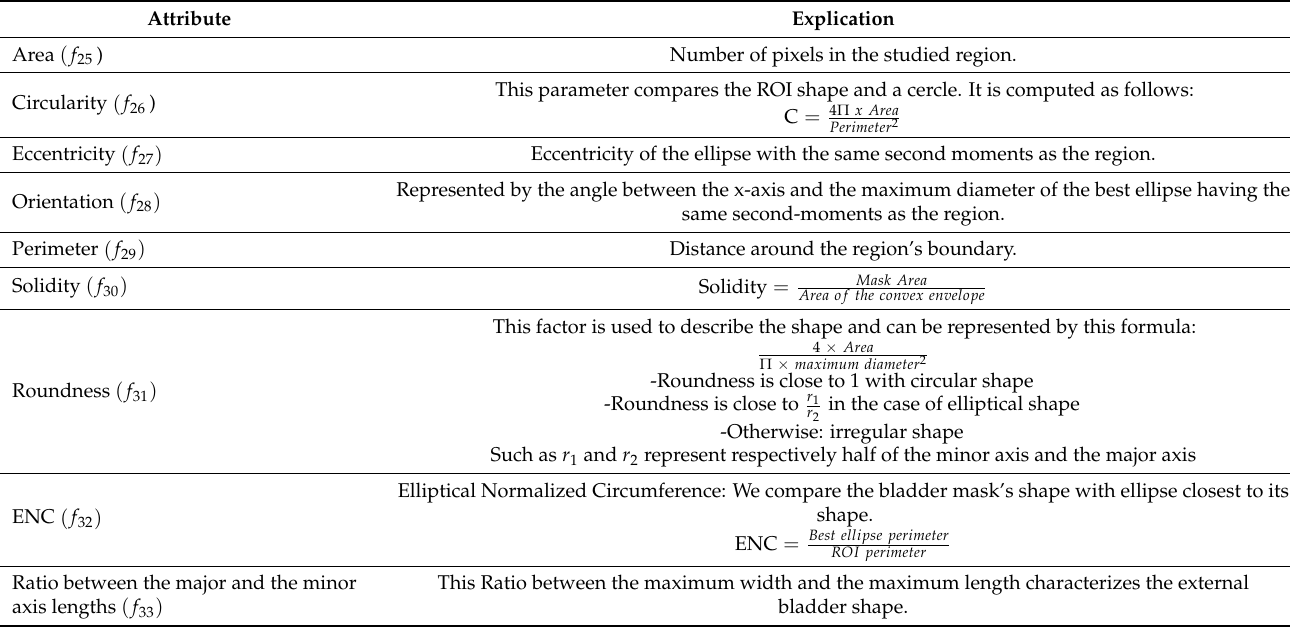
Table A2. Details of the computed morphological